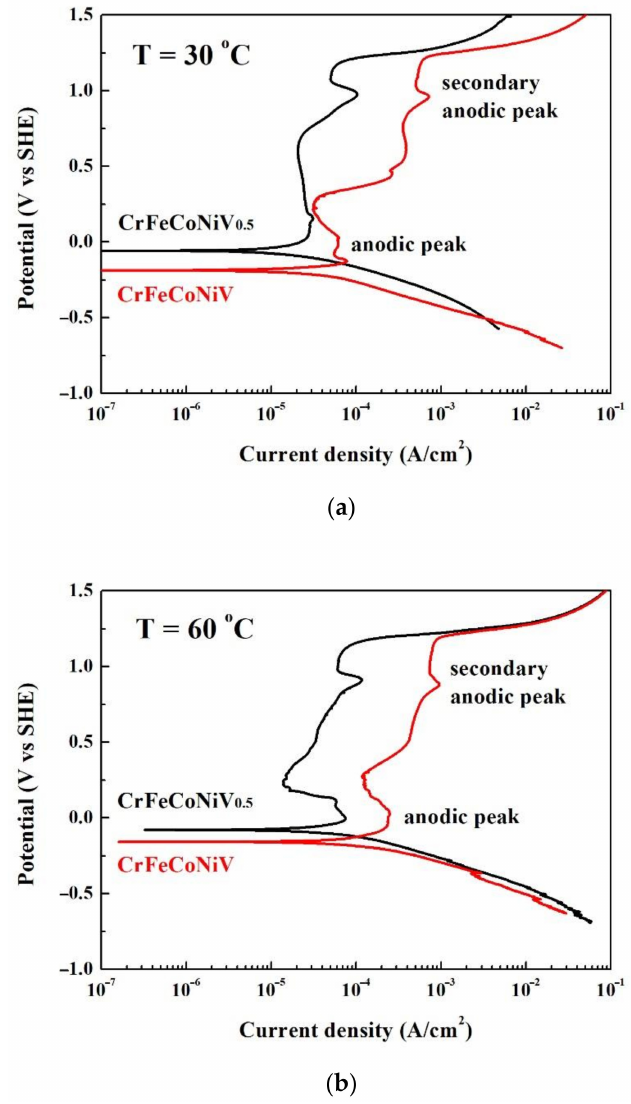
Figure 3. Potentiodynamic polarization curves of as-cast CrFeCoNiV x alloys tested in 1M deaerated H 2 SO 4 solution at different temperatures: ( a ) 30 ◦ C and ( b ) 60 ◦